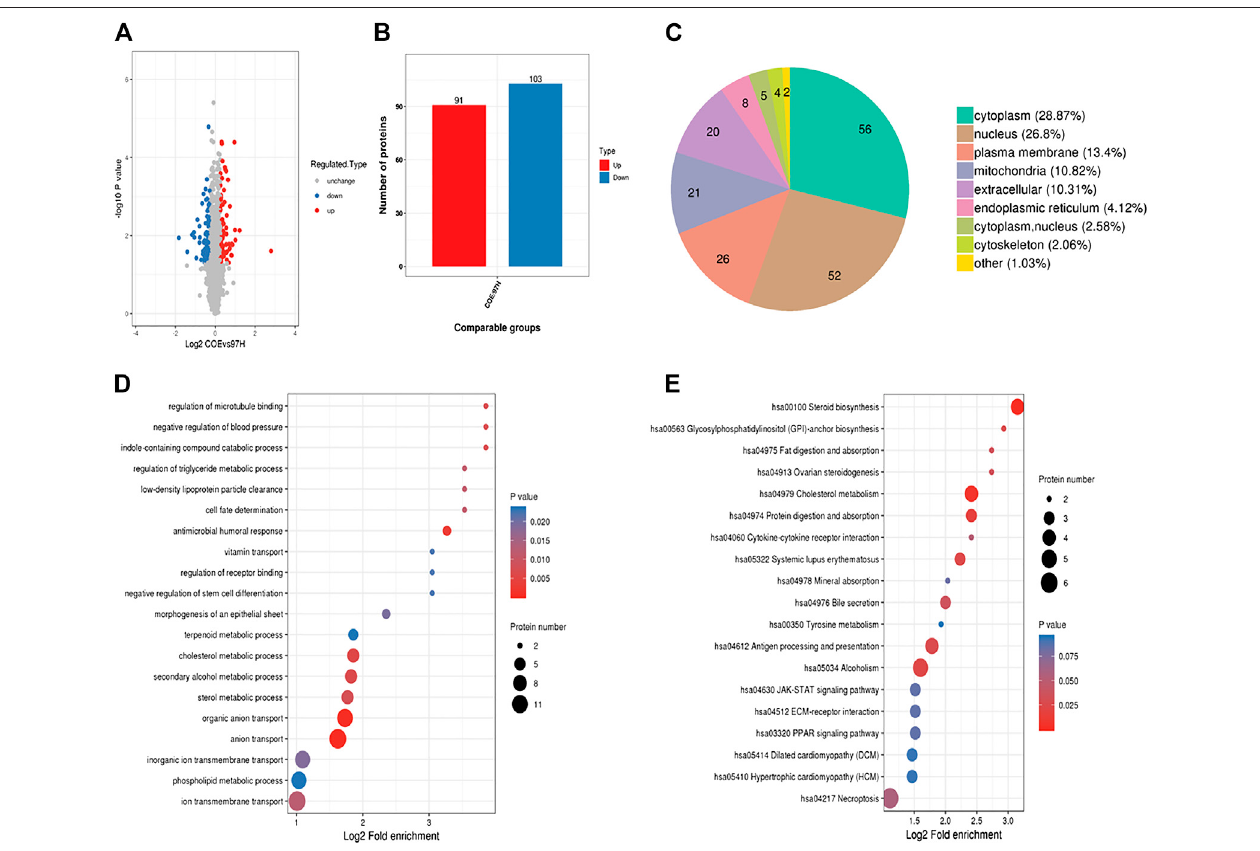
FIGURE 3 | Proteomics analysis on differential proteins in COE treated MHCC97-H cells. (A) , volcano-plots for differential proteins. Blue dots represent down- regulated and red dots represent up-regulated proteins, black indicates no change. (B) , histogram for the number of signi fi cantly changed proteins. (C) , pie graph for origination of differential proteins in MHCC97-H cells. (D) , GO analysis for related proteins. (E), KEGG analysis for related proteins.